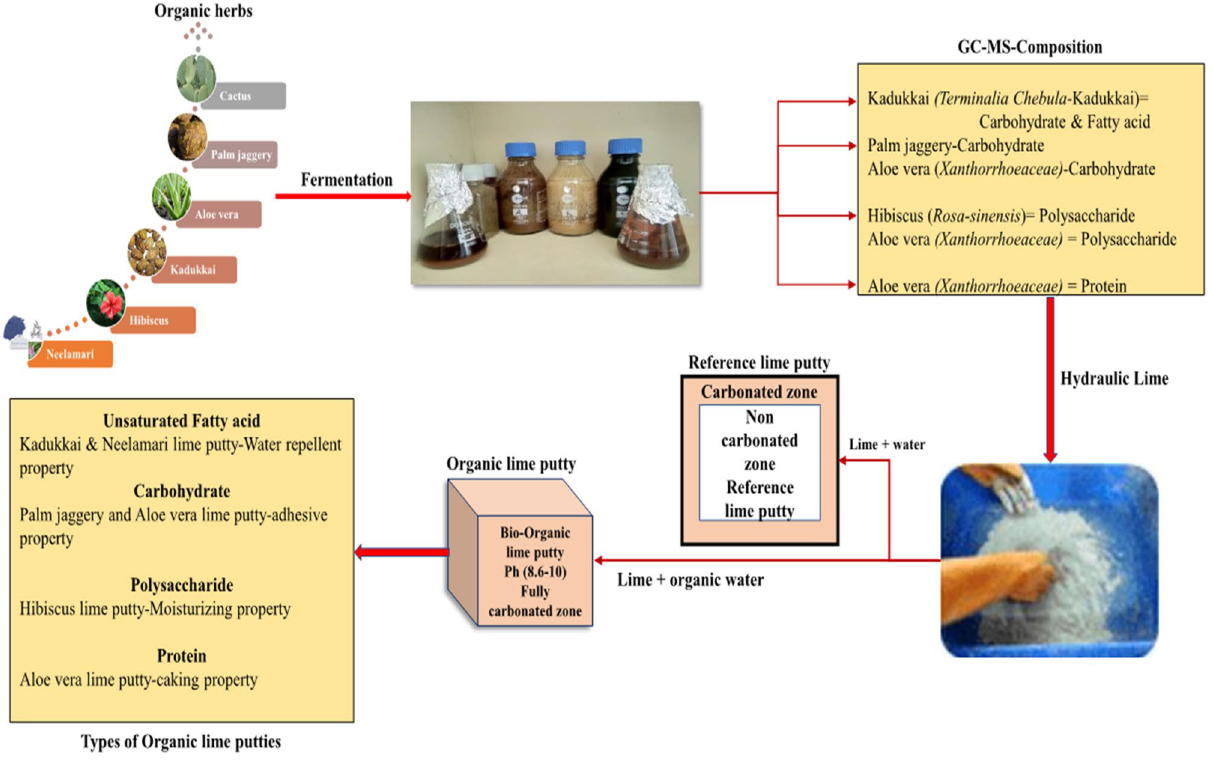
Figure 3. Process of organic lime putty. Proportions of organic lime